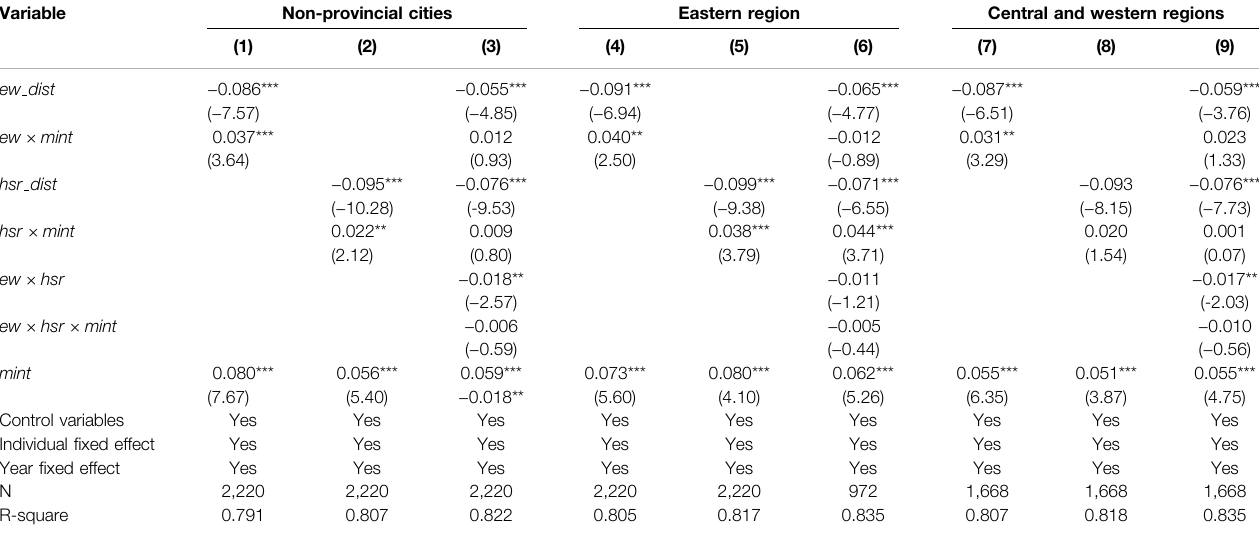
TABLE 6 | Regression results of Sub-sample. Variable